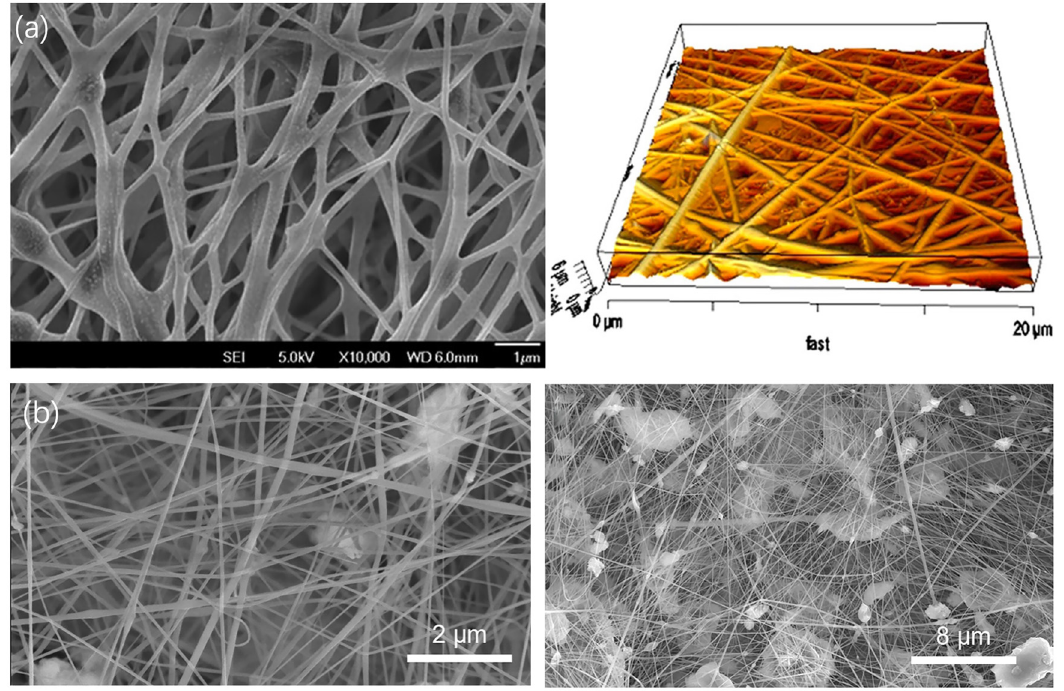
Figure 6: Various HA - based sca ff olds constructed by electrospinning. ( a ) The SEM and 3D AFM of poly ( L - lactic acid )- co - poly ( ε - caprolac - tone )- silk fi broin – hydroxyapatite – HA nano fi brous sca ff olds [ 100 ] . ( b ) The SEM images of nano fi bers composed of HA oligosaccharides and collagen [ 101 ] .